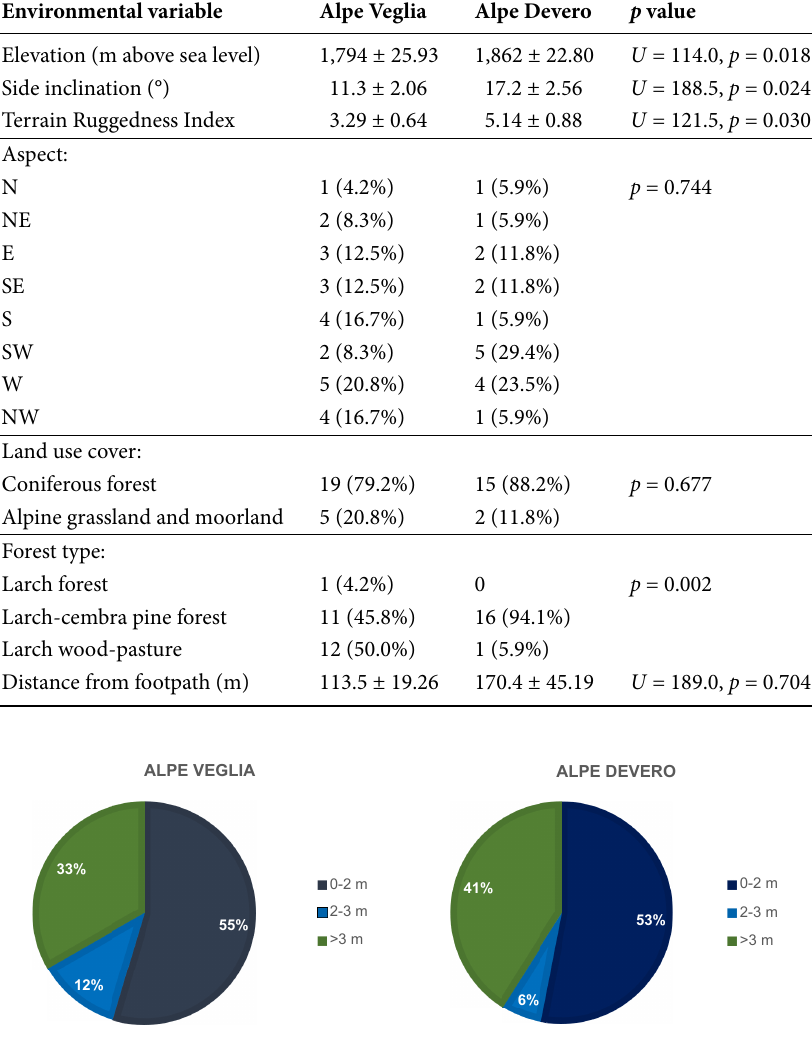
Table 1 Summary of the results of spatial analysis.